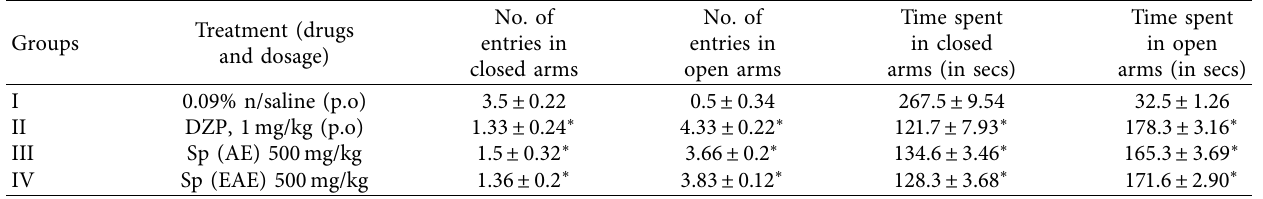
Table 2: Efect of Sp extracts in the EPM